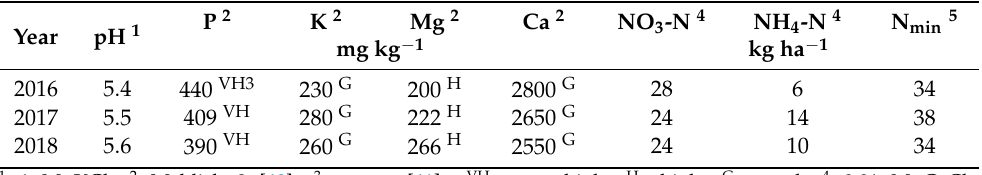
Table 1. Topsoil agrochemical properties before tomato